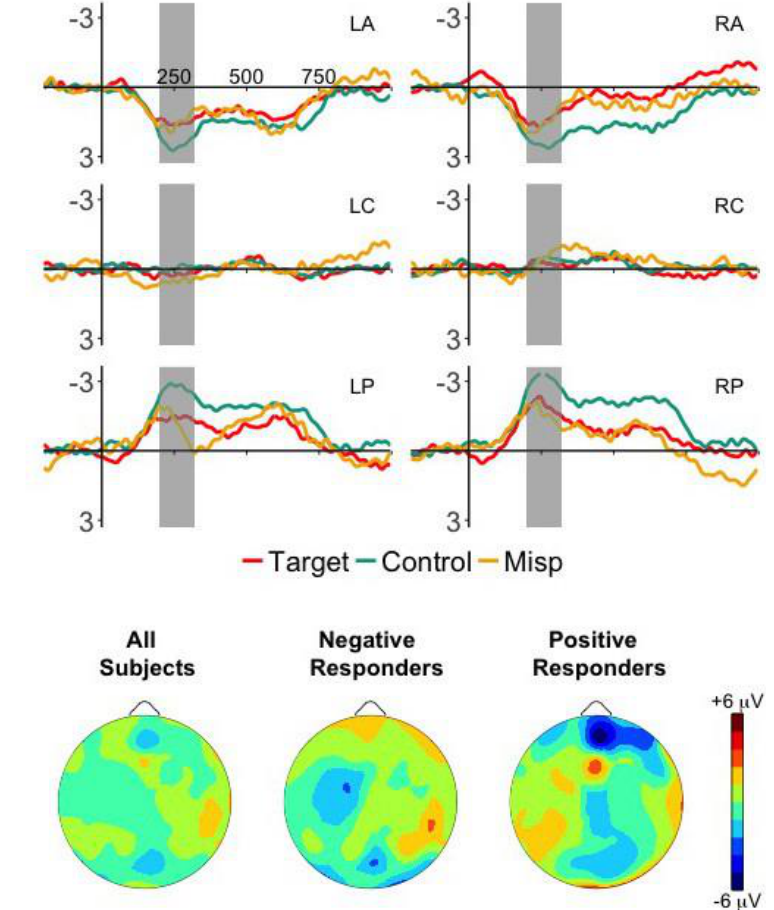
Figure 6. ( a ) Grand-average event-related potentials (ERP) responses time-locked to word onset for target words and medial vowel mispronunciations in the Test Phase for the 6 ROIs: left anterior (LA), right anterior (RA), left central (LC), right central (LR), left posterior (LP), right posterior (RP). The time window of interest, 200–320 ms is highlighted in gray. ( b ) Mean distribution plots for the ERP effect of mispronunciation sensitivity in the Test Phase (target words—medial vowel mispronunciations) in the 200–320 ms time window for overall group performance (left), Negative Responders (central), and Positive Responders (right).